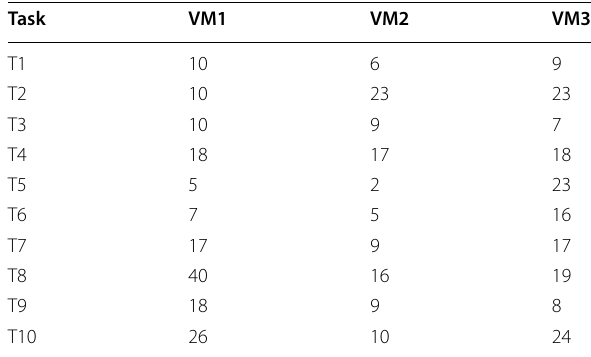
Table 1 Probable Execution Cost (PEC)